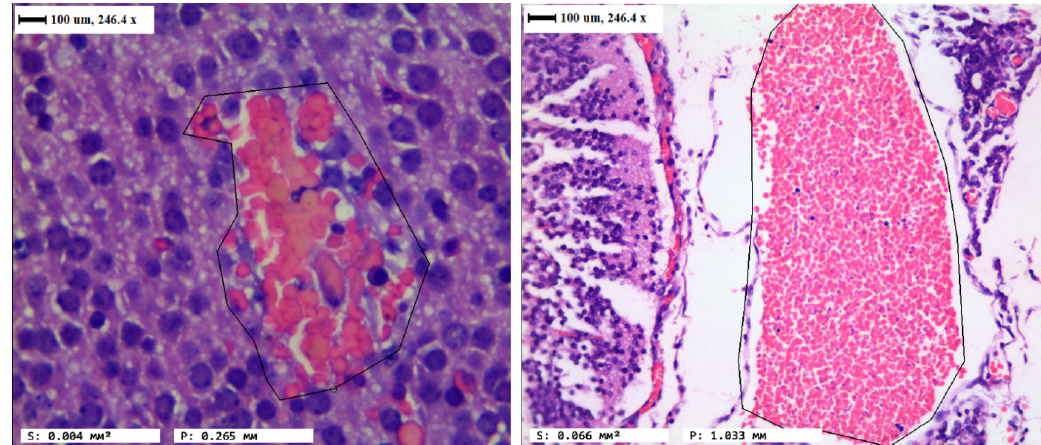
Fig. 2. The typical example of size of stress-induced hemorrhages in the brain of newborn (on the left) and adult (on the right) rats assessed by histological methods. Haematoxylin and Eosin staining.